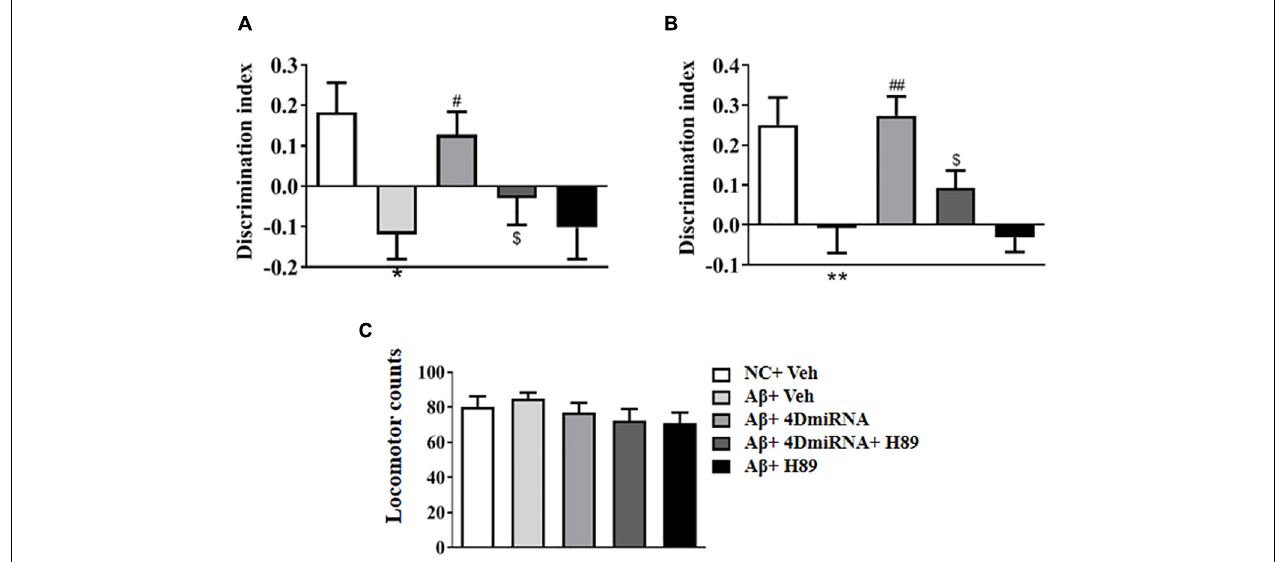
FIGURE 2 | PDE4D deficiency improved cognition and memory in the novel object recognition test in A β 1–42-treated mice. The discrimination index 3 h (A) and 24 h (B) after the training session was recorded after microinjection of lenti-PDE4D-miRNA into the prefrontal cortex for 2 weeks. In the open field test, the total distance traveled did not shown a change after PDE4D deficiency. (C) Values were the means ± SEM with 12 mice in each group. * P < 0.05, ** P < 0.01 vs. control group (NC); # P < 0.05, ## P < 0.01 vs. A β +Veh group; $ P < 0.05 vs. A β +4DmiRNA